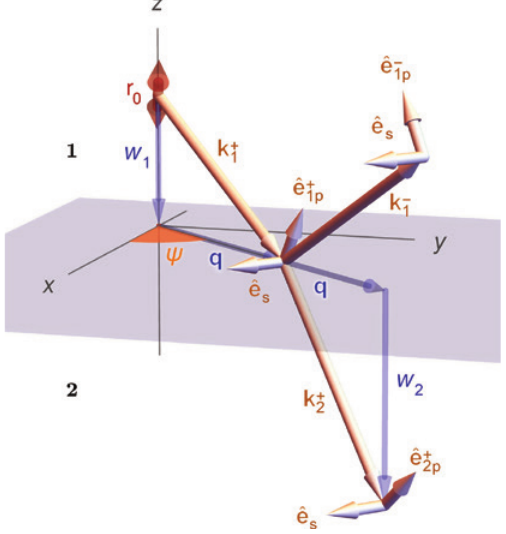
Figure 1: General geometry of dipole emission above an interface. An oscillating electric dipole (red double arrow) is located at = ( ρ position r , z ) within medium “1” above an interface dividing it 0 0 0 from a medium “2” below the interface. The figure shows the vectors that define one of the plane waves that contribute to the dipole’s electromagnetic emission. The wave vector of a directly emitted , + k and the wave vector of its reflection from the interface wave is 1 ˆ ± e represent the directions of the electric . − k The unit vectors is 1 1p field vector in the plane of incidence (p-polarization), whereas the unit vector ê points in the direction perpendicular to the plane of s incidence (s-polarization). Shown are also the wave vector and the p- and s-polarization vectors of the plane wave transmitted into medium “2”. The projections of all wave vectors into the interface are all equal and denoted by q . The projections along the vertical z - axis are ± w and w . The angle ψ is the angle between the horizontal 1 2 projections q of all wave vectors and the x -axis. The “interface” itself can be any stack of planar layers of different